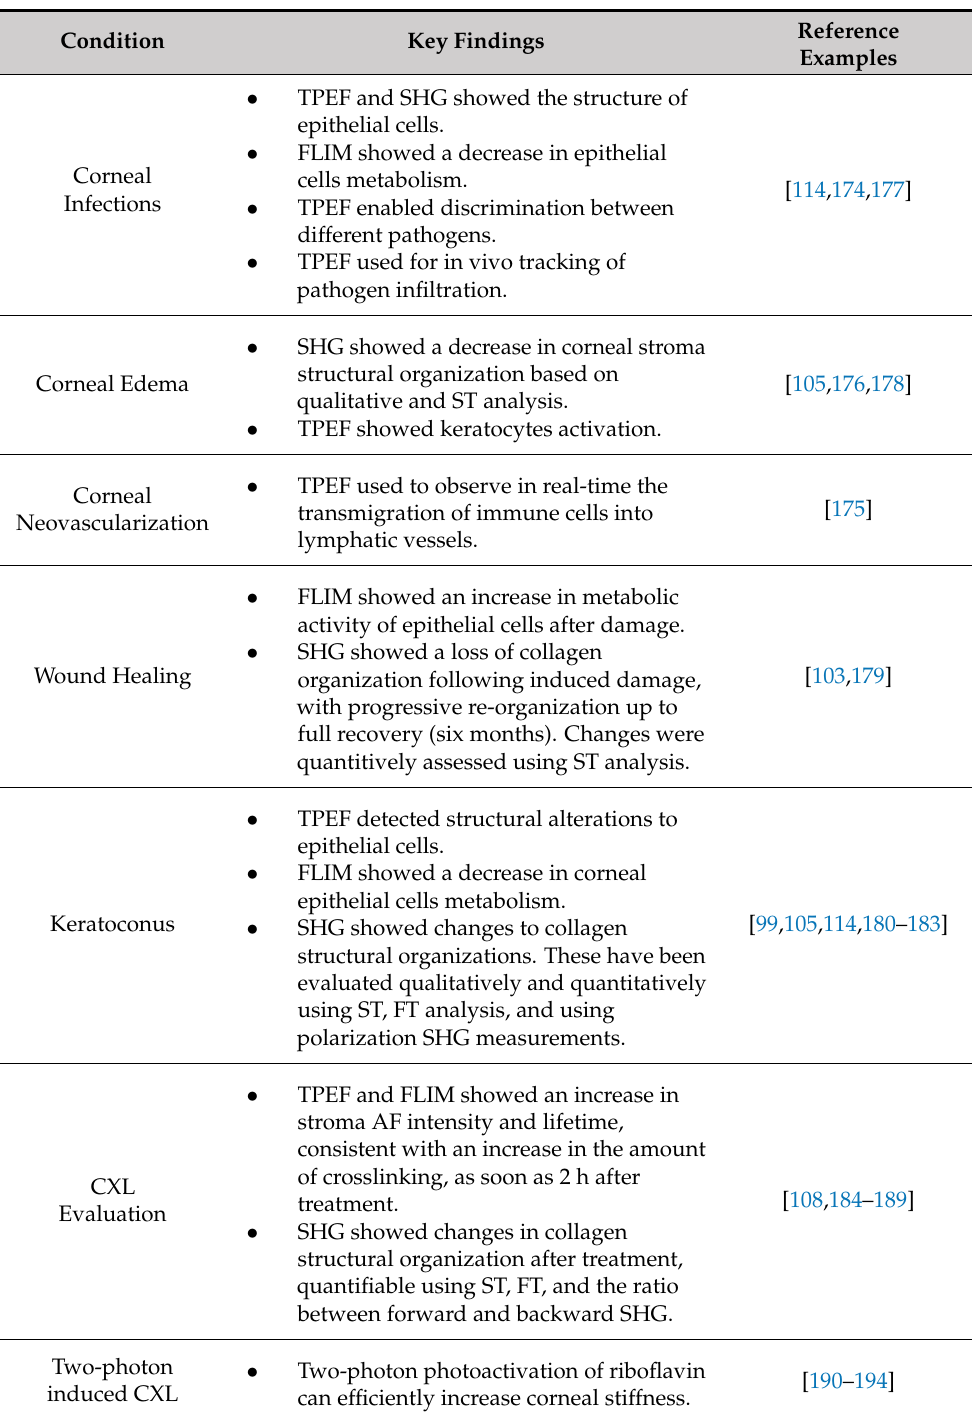
Table 2. Overview of two-photon imaging clinical